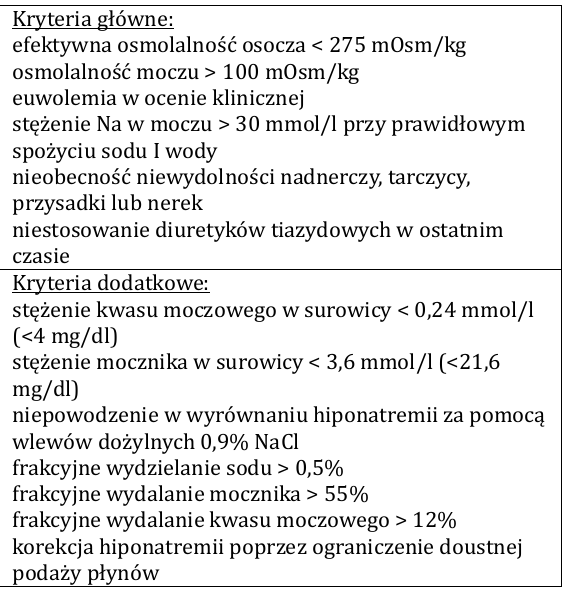
Tabela 4. Kryteria rozpoznania SIADH (Za: Spasovski, G. et al.)